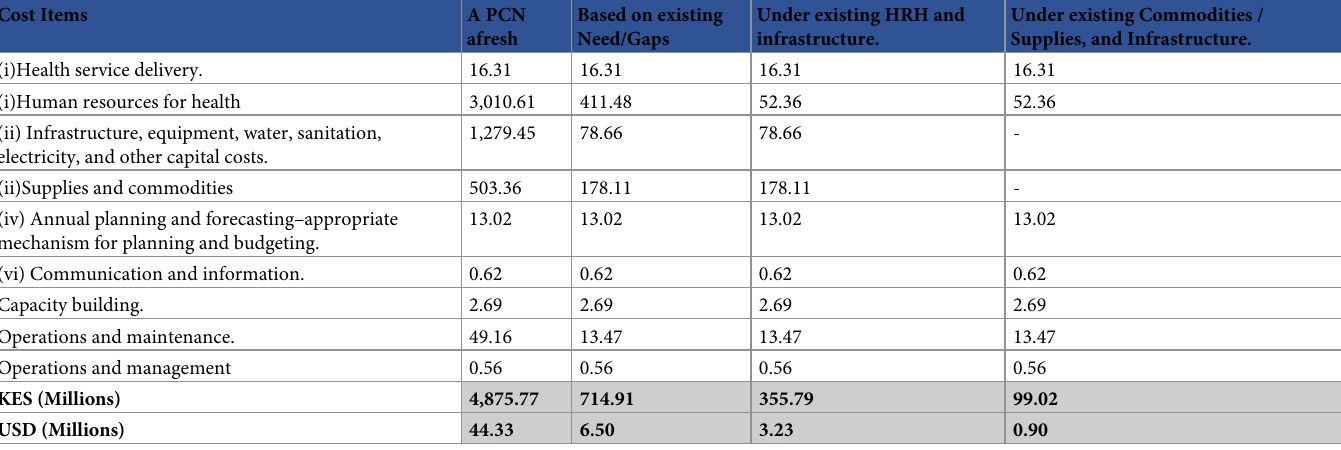
Table 2. Cost of setting up Primary Health Care Networks (PCNs) under various assumptions. Cost Items A PCN